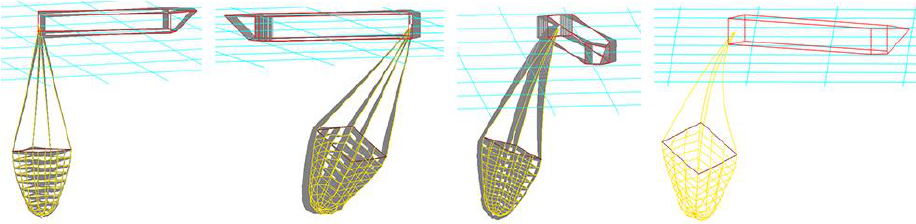
Figure 23. Shape changes of rigid truss trawl rotating towing under fixed turning radius at v = 4 m/s.